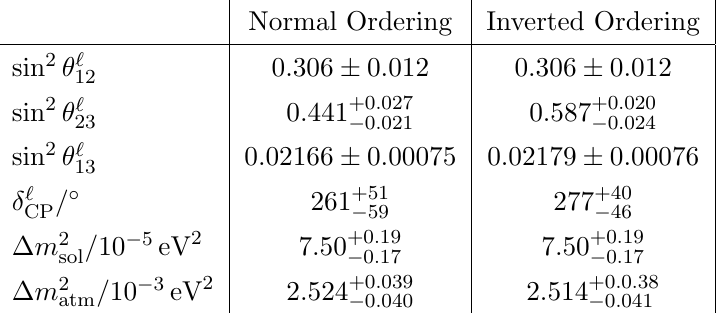
(cid:17) m 2 (cid:0) m 2 , and (cid:1) m 2 (cid:17) m 2 (cid:0) m 2 for NO and (cid:23) 2 (cid:23) 1 atm (cid:23) 3 (cid:23) 1 sol